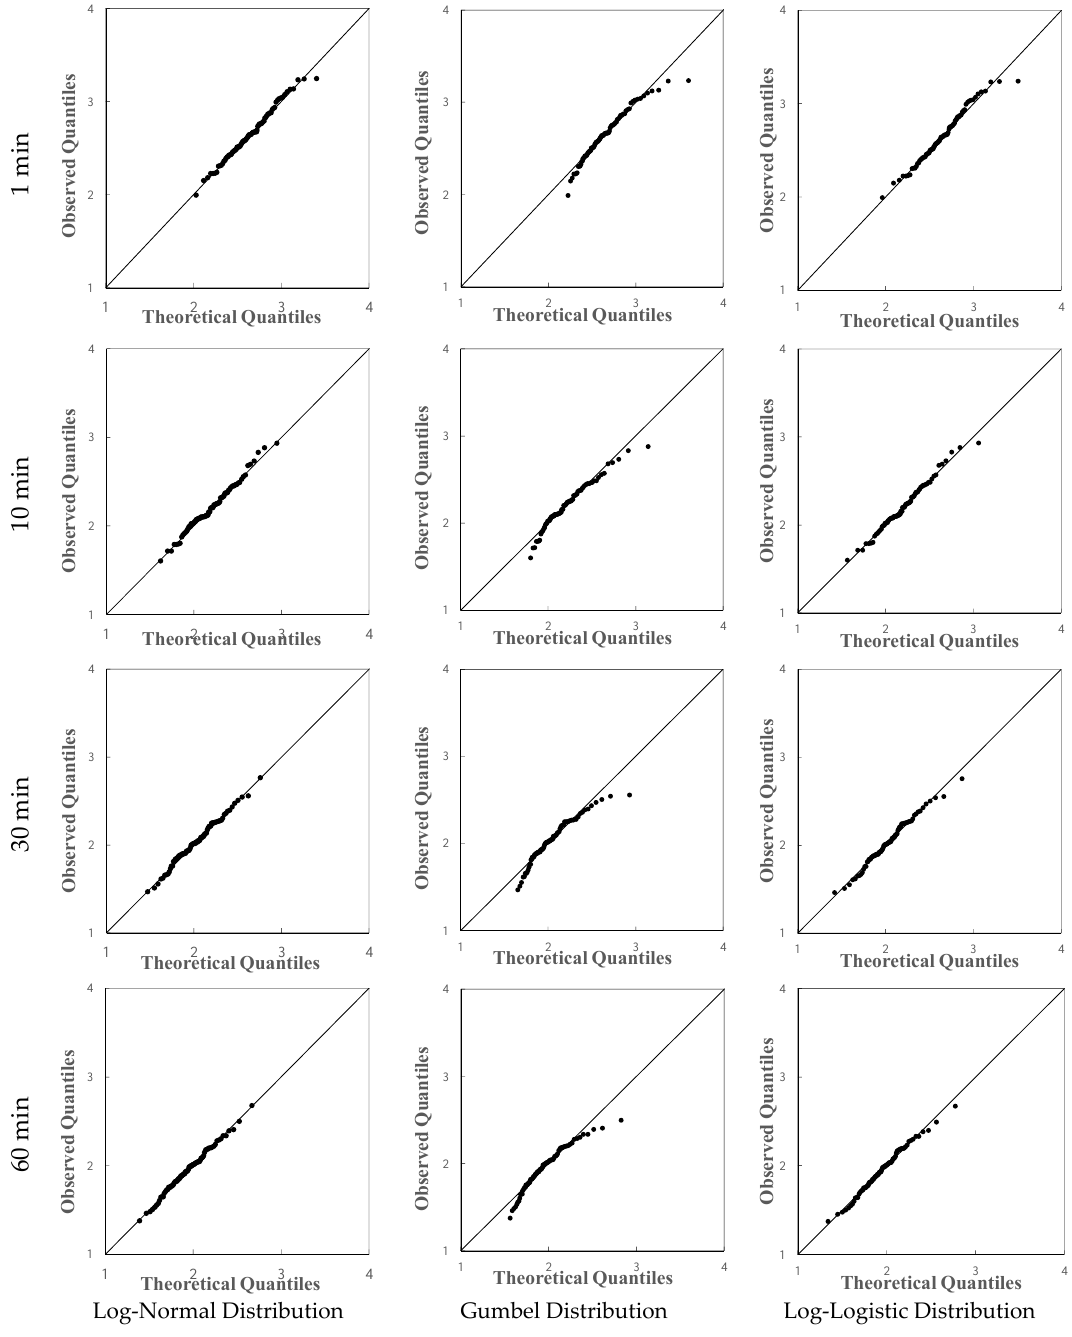
Figure 5. Q ‐ Q plots of the peak demand coefficient for N us = 981 (PSG) for various time aggregations and distributions ( LN , Gu and LL ).